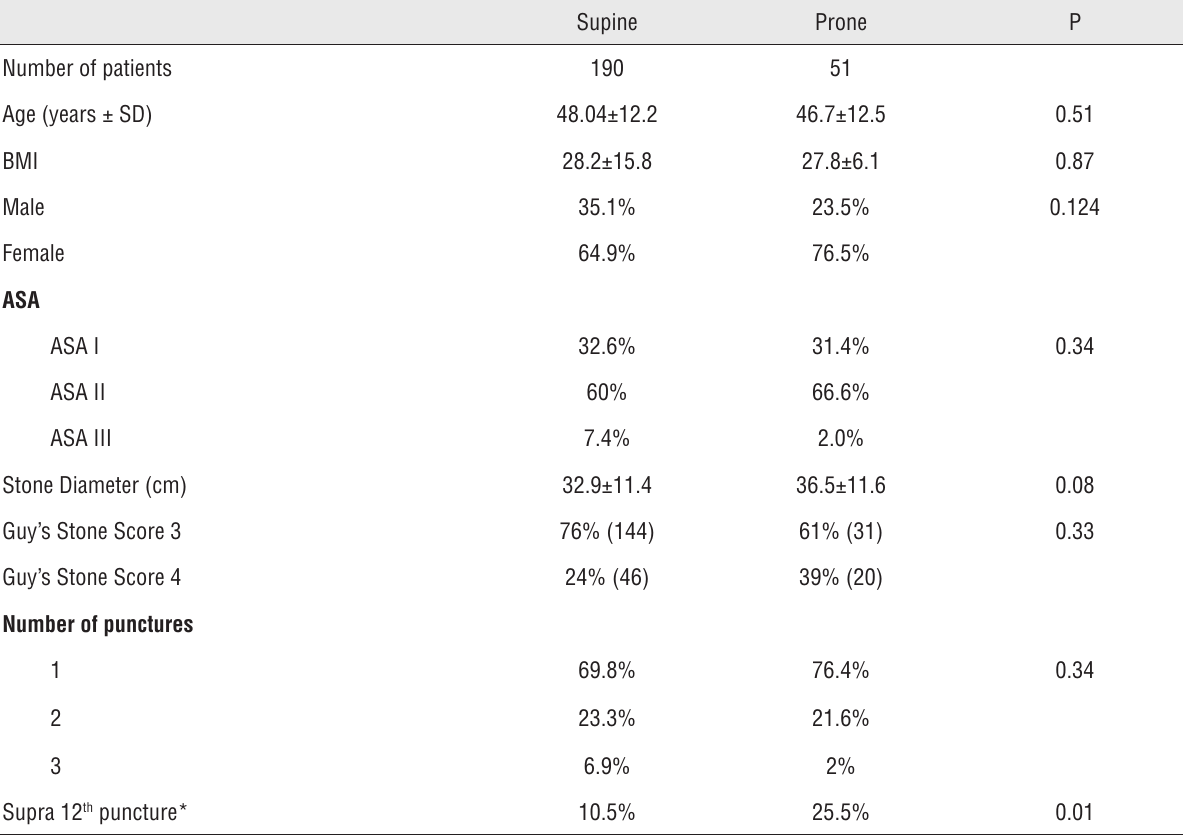
Table 1 - Demographic and clinical characteristics of patients. Distribution according to a prone or supine position. Supine